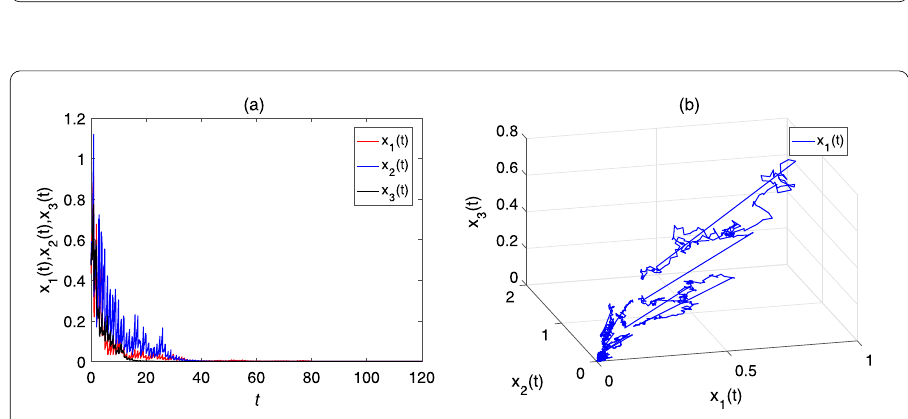
Figure 8 Impulsive perturbations to system (2): stochastic permanence to extinction. (a) Time sequence diagram and (b) the phase portrait of system (2).( x 1 (0), x 2 (0), x 3 (0)) = (0.5,0.5,0.5), σ 2 σ 2 σ 2 1 ( t ) = 2 ( t ) = 3 ( t ) = 0.1 + 0.04sin